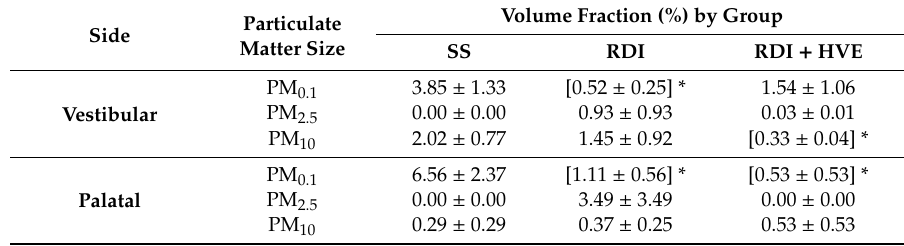
Figure 2. Curve distribution of volume fraction of the dental aerosolized particles under 10 µ m. ( a ) The vestibular side shows an increased volume fraction for particles below 0.1 µ m for the SS group, when compared to the RDI and RDI + HVE groups. ( b ) In the palatal side, the volume fraction distribution follows a similar pattern seen in ( a ), except for the RDI + HVE group. Results are shown as mean ± standard error of the mean (SEM); n = 3. Abbreviations: SS, standard suction; RDI, rubber dam isolation; HVE, high-volume evacuator. X axis (Particle size) is Log 10 scaled. Table 1. Volume fraction of ultrafine (PM 0.1 ), fine (PM 2.5 ), and coarse (PM 10 ) dental aerosol particles.